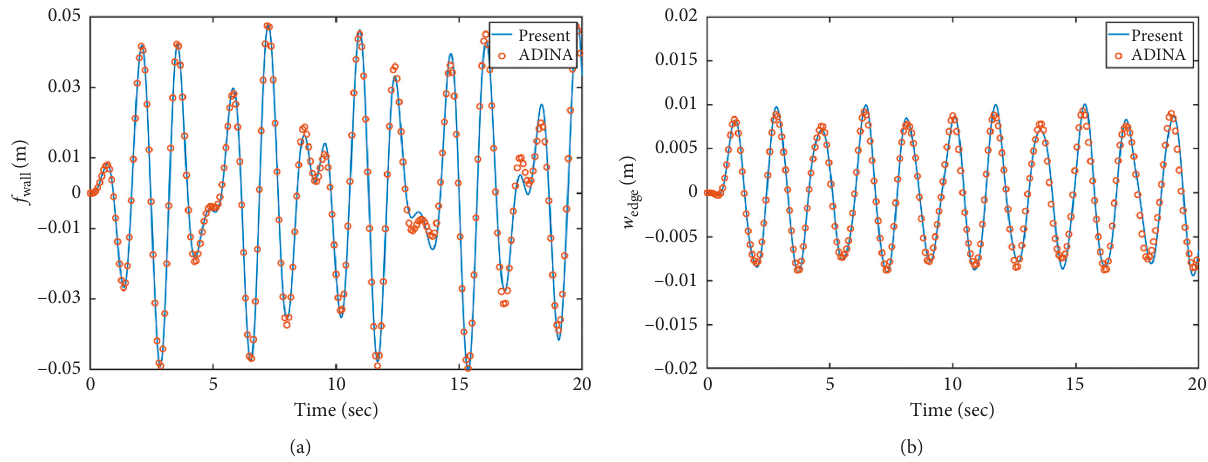
Figure 5: The time histories of the surface wave height on the wall ( θ � 0) and the dynamic deflection of the baffle at the inner edge ( θ � 0) � 5rad/s. (a) surface wave height on the wall, (b) dynamic deflection of the baffle at the inner edge. for ω 0